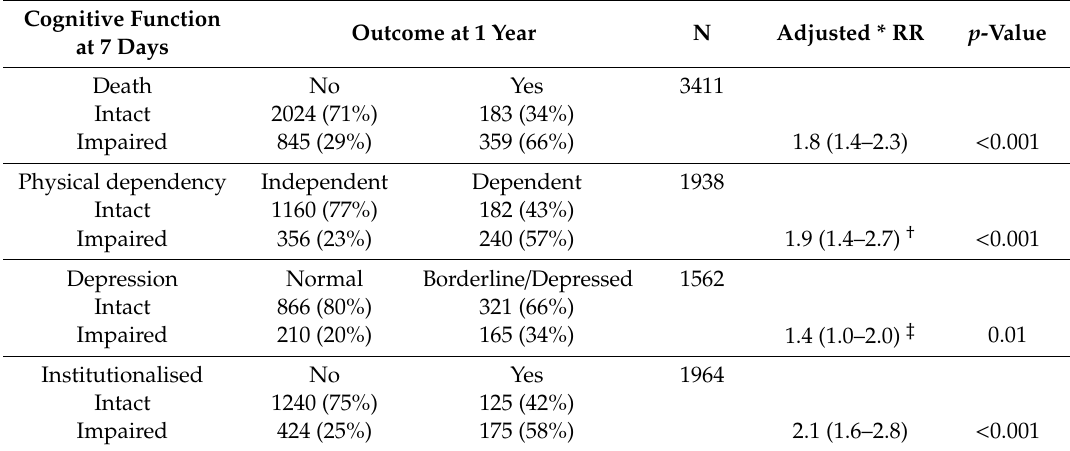
Table 2. One year outcomes by seven day cognitive